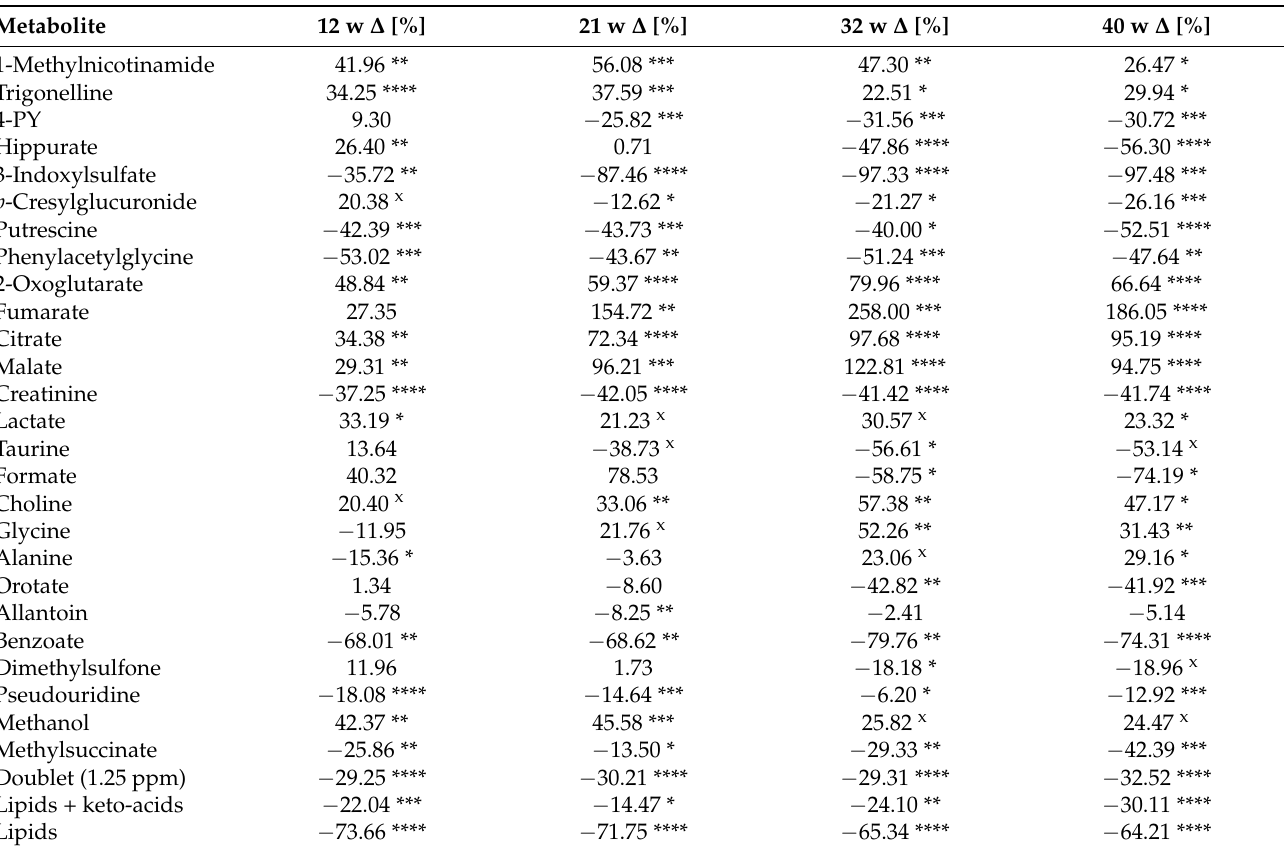
Table 2. Significantly changed metabolites in the urine of fa / fa and control rats at 12, 21, 32, and 40 weeks of age, detected by NMR.